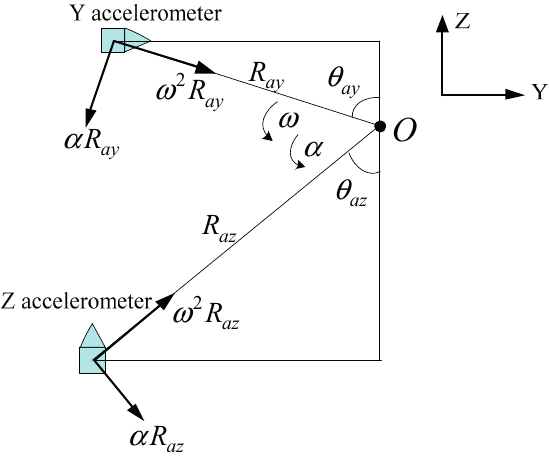
Figure 11. The lever arm effect